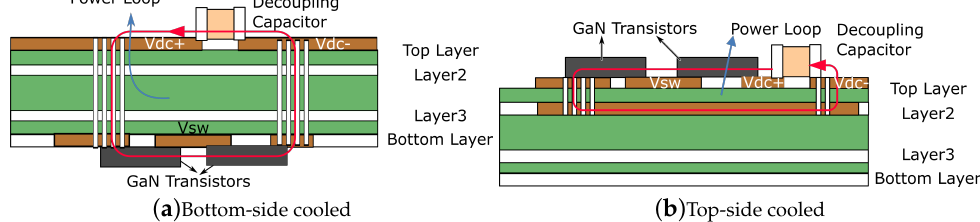
Figure 5. A practical implementation of ( a ) bottom-side cooled ( b ) top-side cooled GaN devices on a 4-layer PCB (derived from [9,80]).